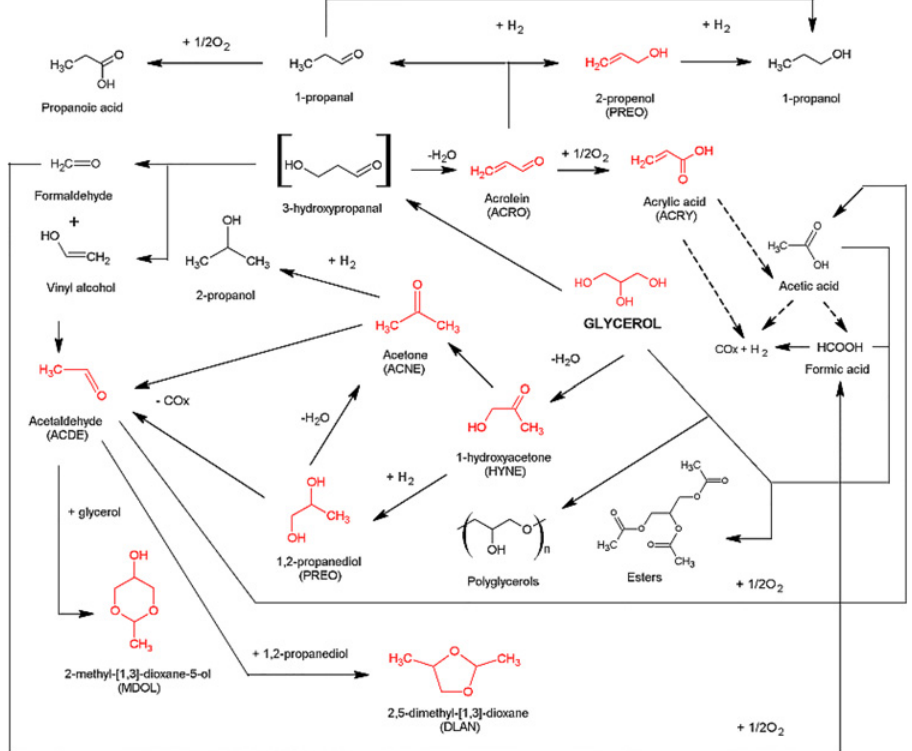
Fig 5. Reaction network during glycerol dehydration. The products that were identified in the current study are marked in red. For the comparison of the identified products with those reported in the literature see review [11], updated by the recent studies [26 –